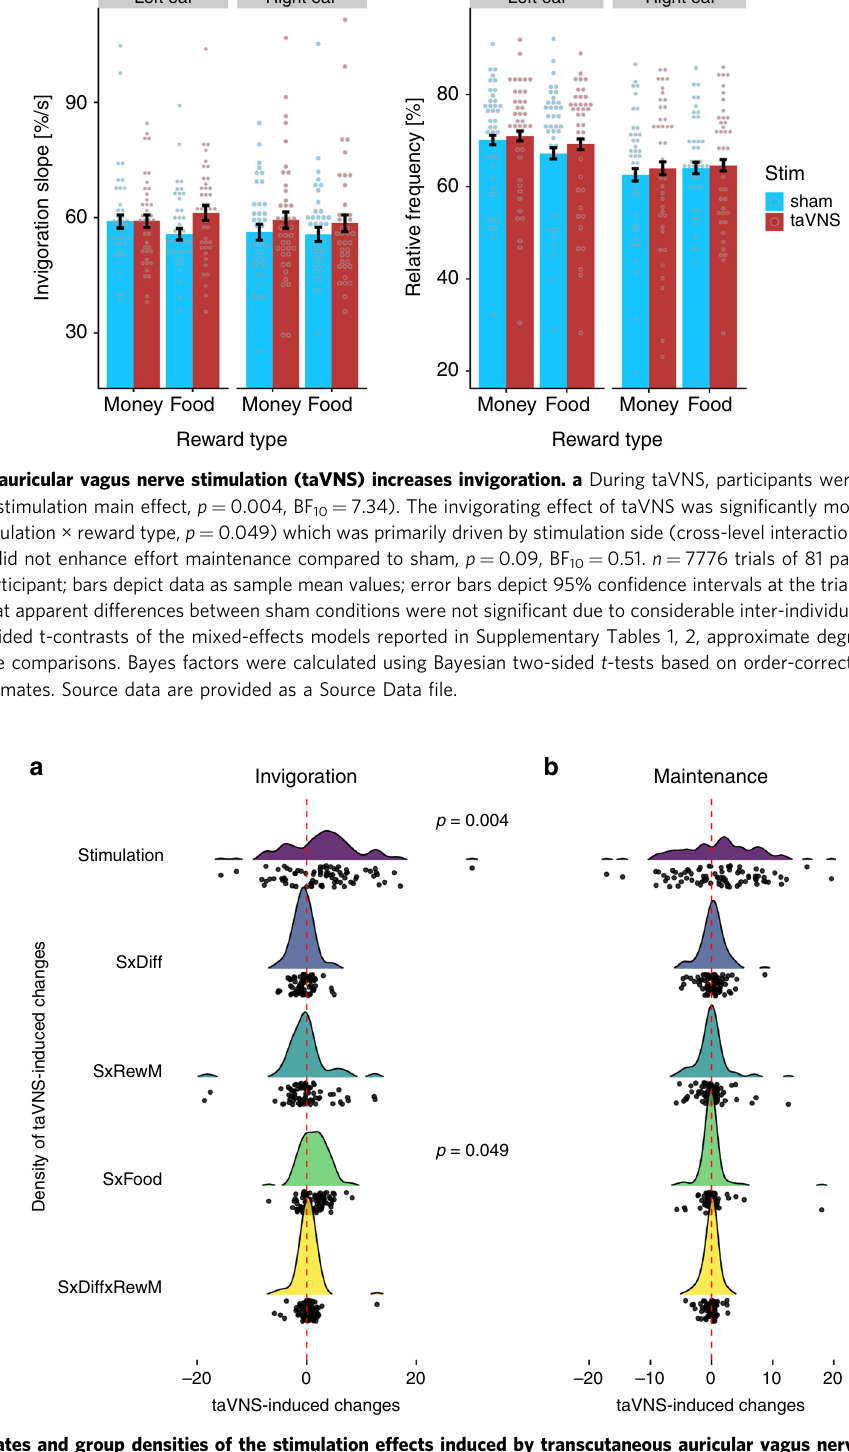
Fig. 4 Individual estimates and group densities of the stimulation effects induced by transcutaneous auricular vagus nerve stimulation (taVNS). a During taVNS, participants showed an increase in invigoration across conditions (main effect of stimulation, S; b = 2.93, 95% CI [0.98, 4.88], p = 0.004). The S × Food interaction was signi fi cantly higher during taVNS, ( b = 1.33, 95% CI [0.03, 2.63], p = 0.049) which was primarily driven by stimulation on the left side. b No signi fi cant changes in effort maintenance were induced by taVNS. Diff = dif fi culty, RewM = reward magnitude. The plot depicts empirical Bayes estimates (after taking the distribution across the group into account). Statistics refer to two-sided t -contrasts of the mixed-effects models reported in Supplementary Tables 1, 2, approximate degrees of freedom = 78, no adjustments for multiple comparisons. Source data are provided as a Source Data fi